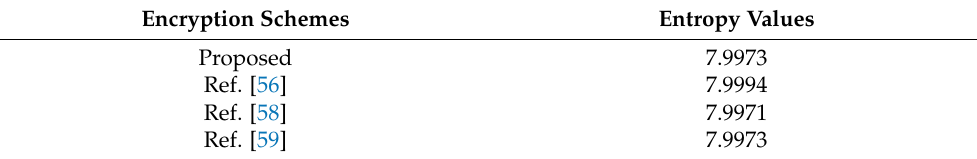
Table 10. Entropy values of the Lena image encrypted by different comparison